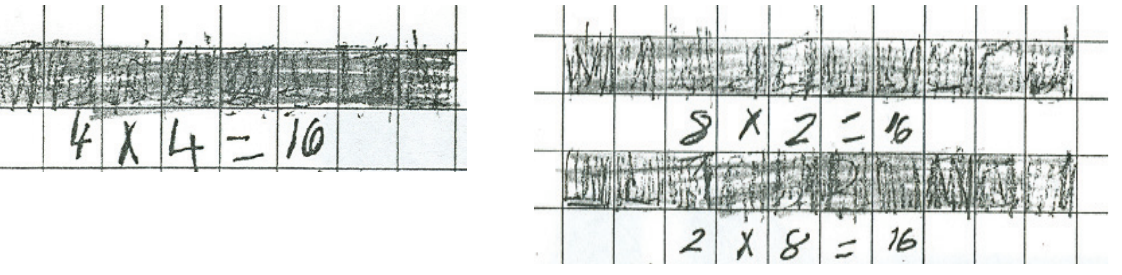
Figure 5 : A third grade student’s transition to multiplicative thinking The third grade student’s emergent multiplying scheme is related more to additive thinking in spite of the multiplication sign. For example, 4×4 = 16, represents counting  4 + 4  which equals 8. On the right side, the counting is 8+2 (=10) and 2+8 (=10). This third grade student’s connection between multiplication and the underlying row and column structure of unit squares or blocks is not there. There was no coordination in the shading and in the counting of the blocks as composite units that yield 16. What we see is what happened despite my instructions to the students on how to coordinate the rows and columns once equivalences have been identified inside Figure